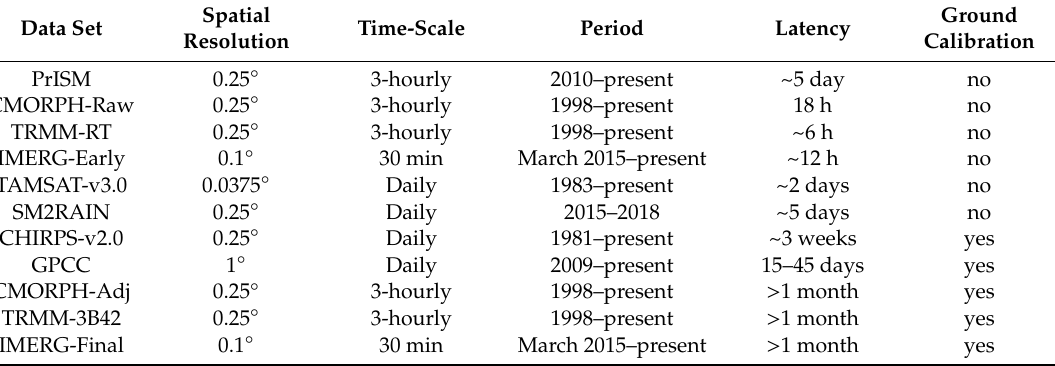
Table 2. Inventory of all satellite rainfall products’ datasets used in the study. To enable the fair comparison of all products, each product was regridded to the 0.25 ◦ spatial resolution and daily